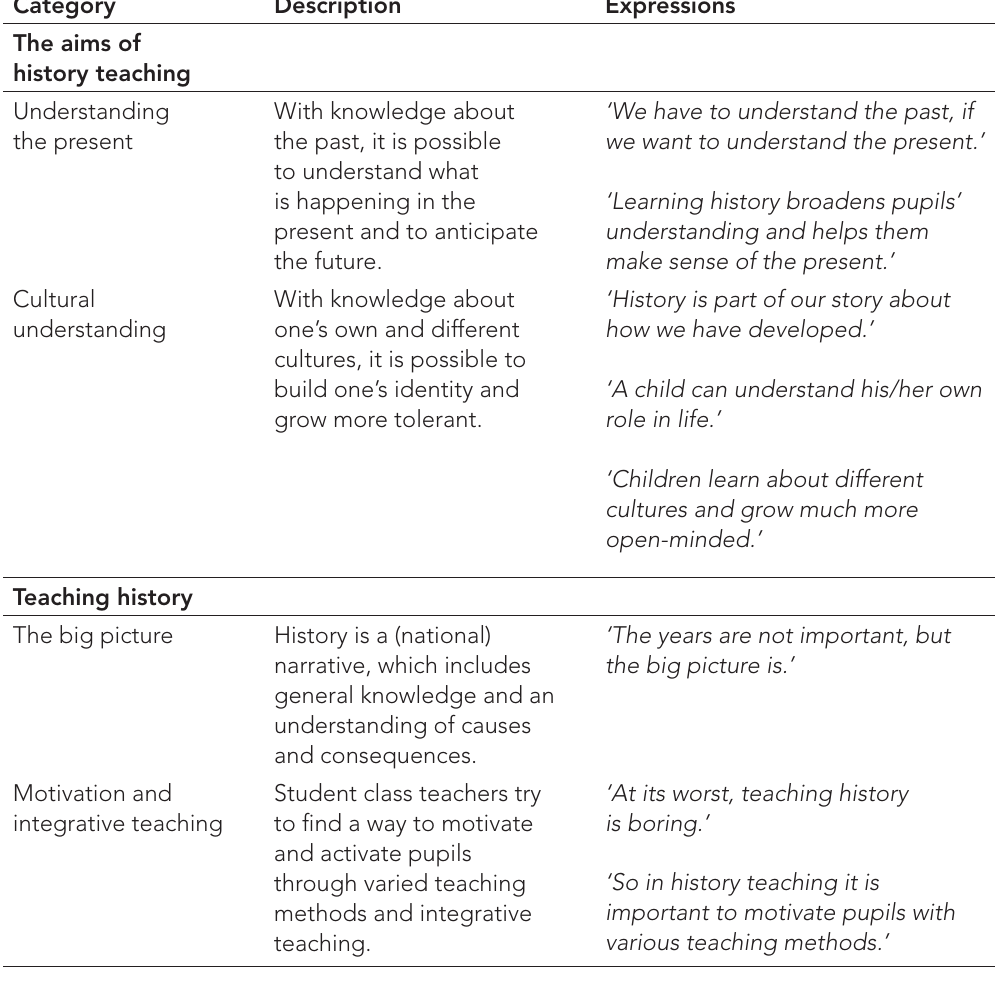
Table 3: Categories showing how student class teachers understood the meaning